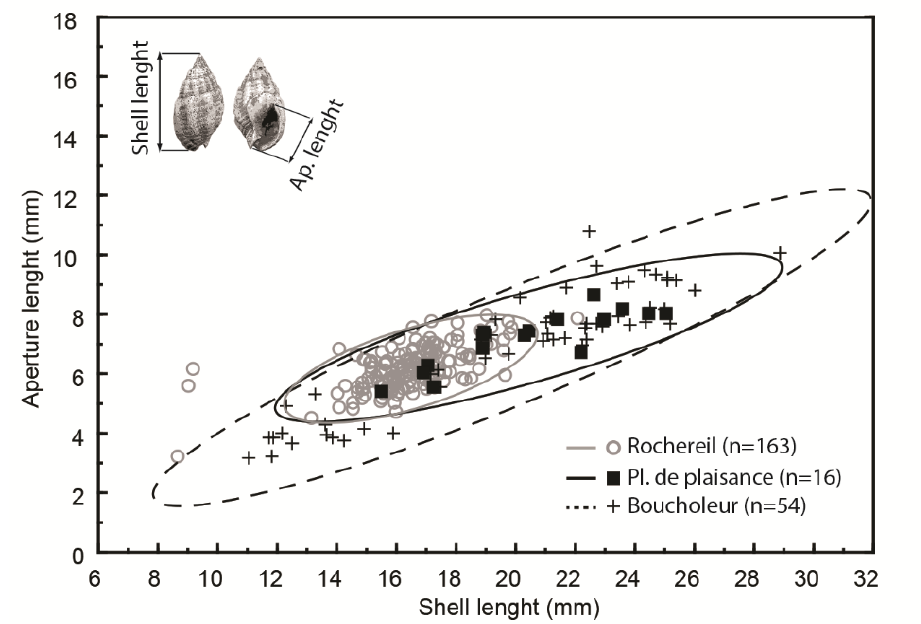
Figure 9: Scatterplot of the length and aperture length registered on the Tritia reticulata from the modern reference collections and the specimens from Rochereil attributed to the Upper